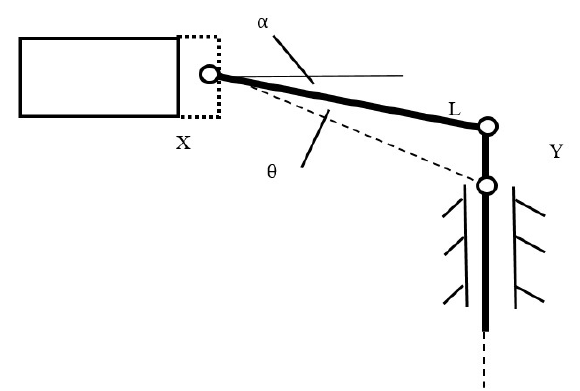
Fig. 14. Schematic diagram of triangular magnifying principle.